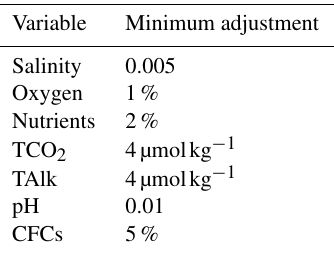
Table 3. Initial minimum adjustment